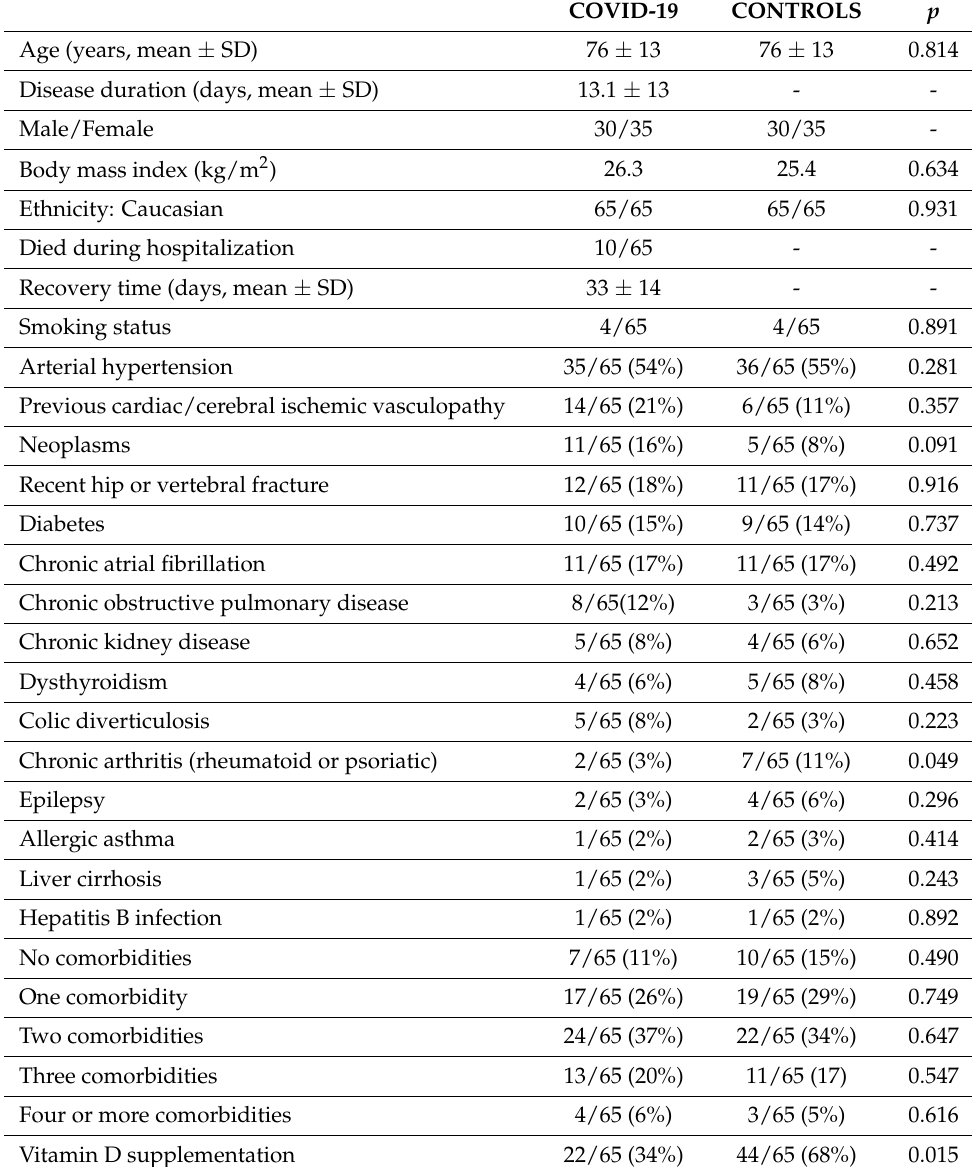
Table 1. Clinical characteristics and comorbidities of enrolled subjects. p = statistical